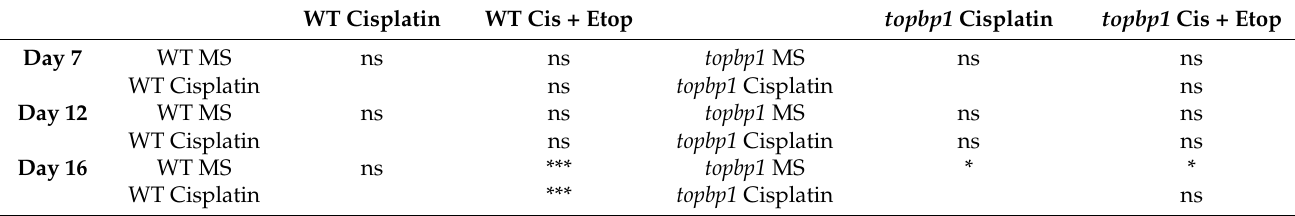
Figure 1. Defects in DSB repair and mitosis in topbp1 mutant. ( a ) Diagram with the mean number of leaves per seedling in the WT and topbp1 mutant grown just in MS medium or supplemented with cisplatin (30 µ M) or cisplatin + etoposide (5 µ M). Data collected from three independent experiments ( n = 100 per treatment and day). ( b ) Mitotic anaphases of the WT and topbp1 . Statistical differences between the WT and topbp1 for each treatment analysed by Mann–Whitney test, *** p < 0.001; ns = not significant. Comparisons among treatments within the same genetic background are shown in Table 1. Scale bar is 5 µ m. Table 1. Results of the pairwise comparison of the mean number of leaves per seedling untreated (MS), treated with cisplatin, and treated with cisplatin + etoposide (Cis + Etop) by the Kruskal–Wallis test followed by Dunn’s post-hoc test in the WT and topbp1 at days 7, 12, and